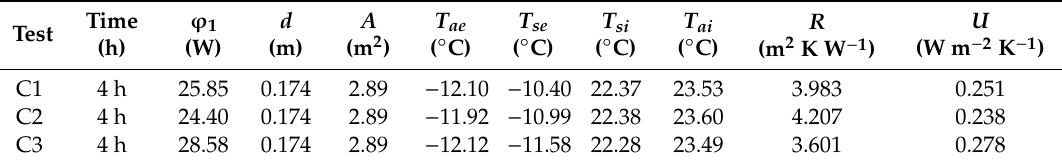
Table 6. Thermal transmittance and thermal resistance values of sandwich panel filled with mineral wool insulation under steady-state conditions.